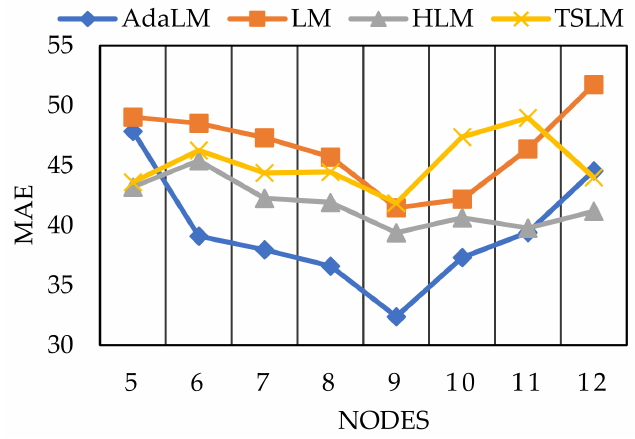
Figure 8. MAE of models with different neural network nodes.